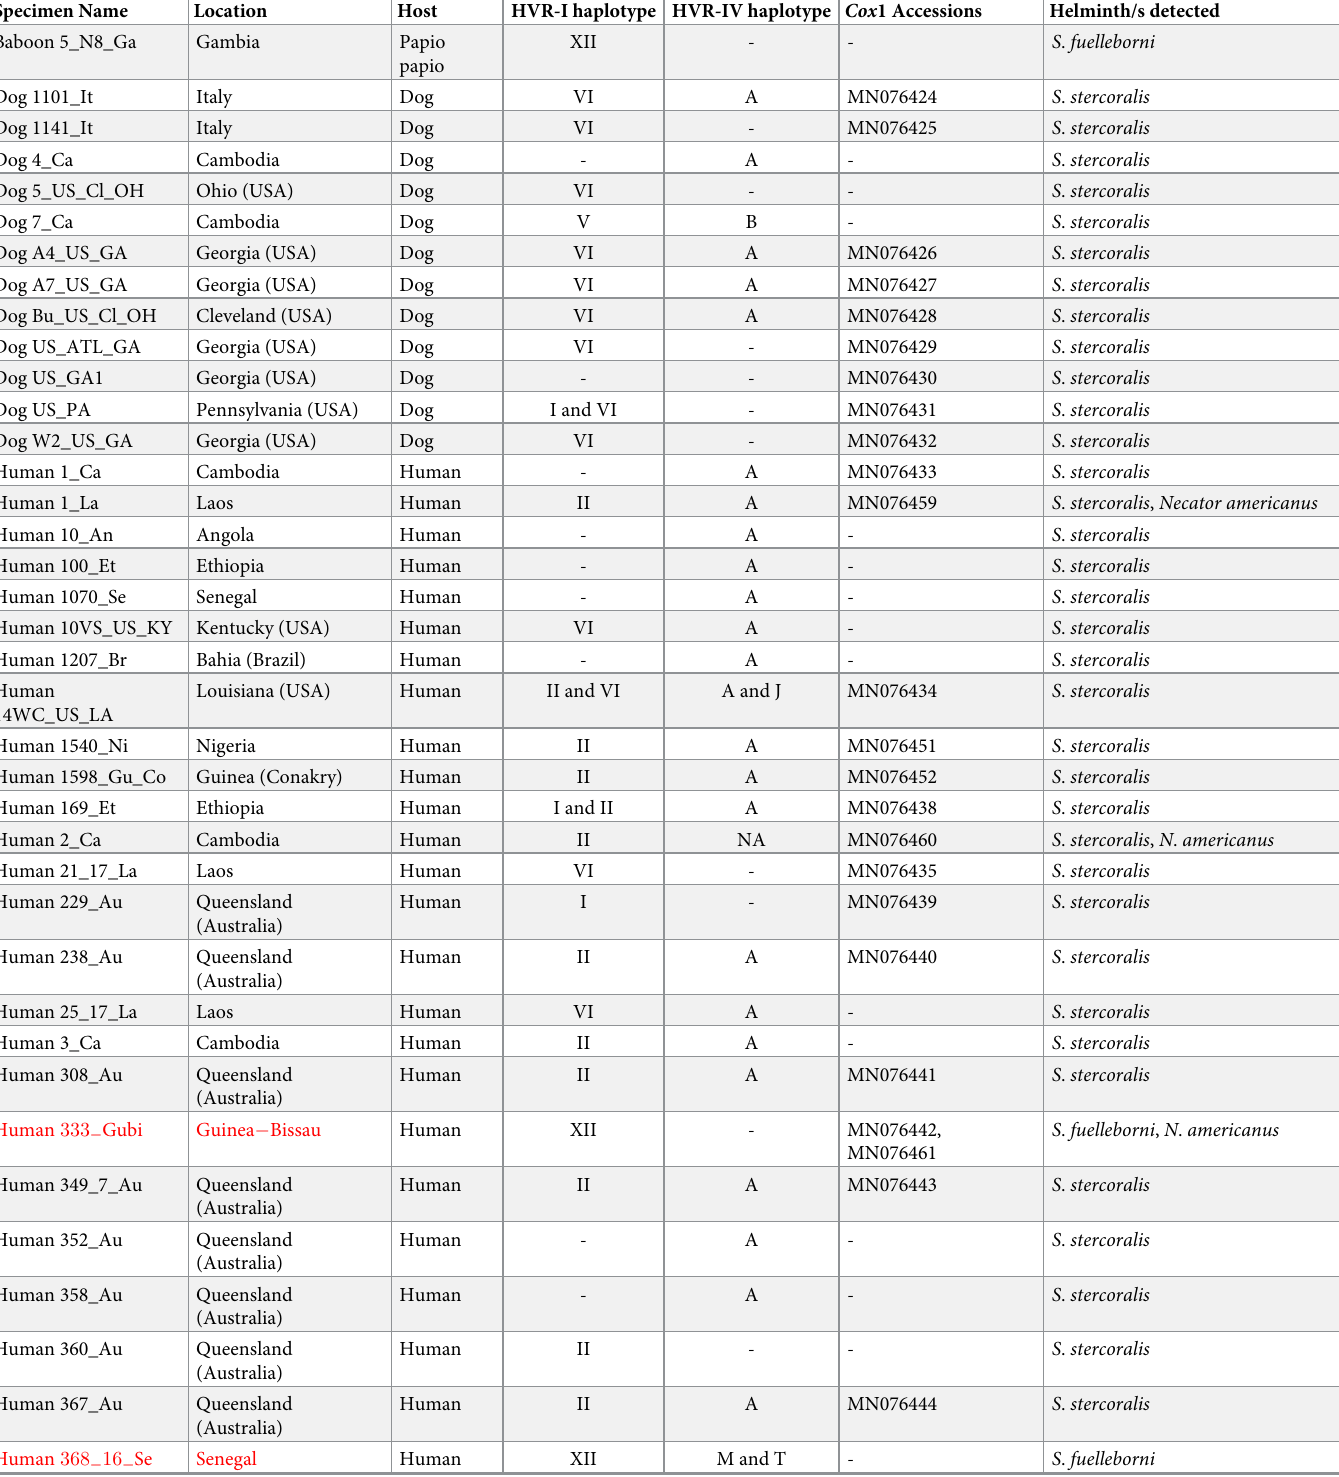
Table 4. Human, primate and dog Strongyloides spp. specimens analyzed in this study and their genotype. Specimen